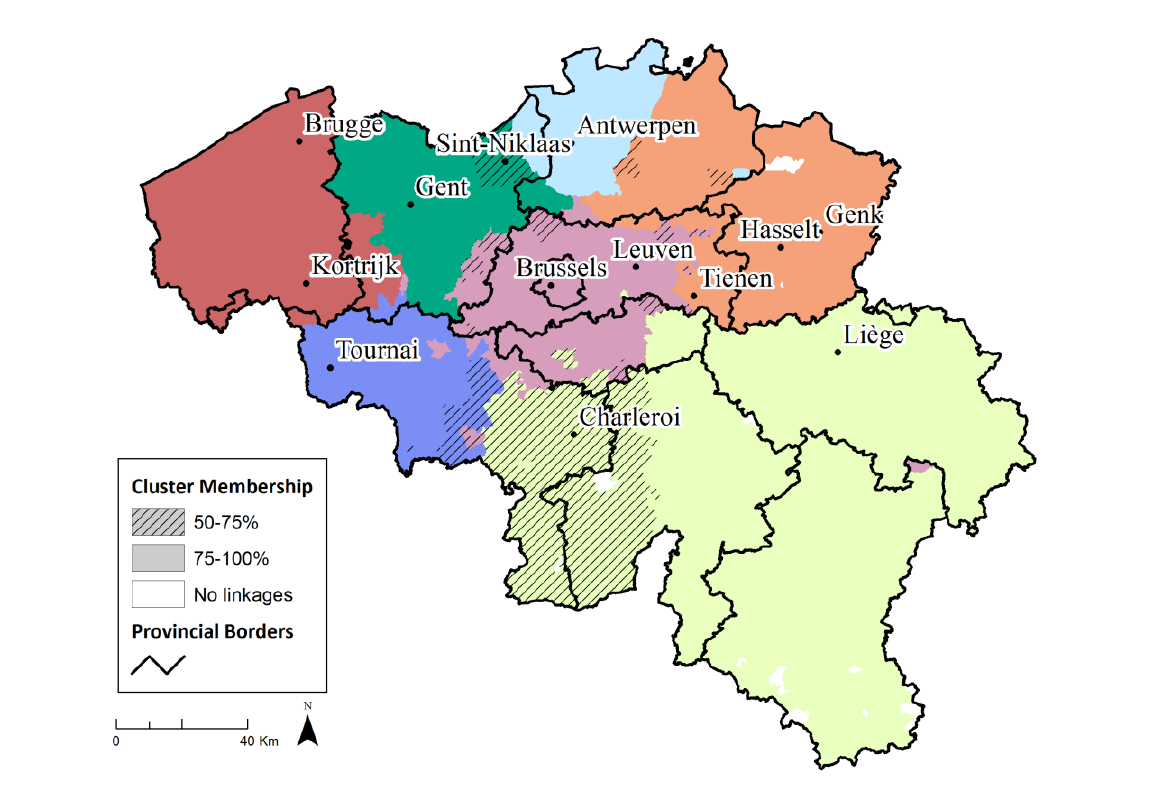
Figure 4: Communities in the buyer-supplier